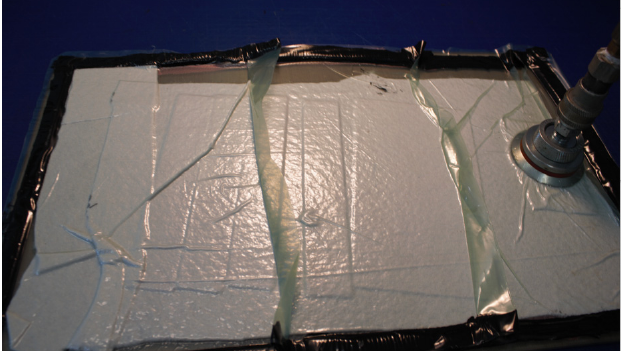
Figure 2. Manufactured process—vacuum package. The samples were rectangular plates with constant overall dimensions of 120 × 80 mm weakened by central cut-outs with variable geometric parameters a and b and with the constant corners’ rounded radius equal to 5 mm. On the shorter edges of the plate above and below the central cut-out, there are technological recesses with a width equal to the width of cut-out b, with the same radius as the cut-out corners. The task of the technological recesses was the constructional separation of zones, where only twisting and bending occur, without the effects of boundary conditions related to the fastening. Experimental validation of E-T and E-B couplings’ influence on plate behavior was per- formed using the Instron universal testing machine modernized by Zwick-Roell and equipped with specially designed grips (Figure 3). The experimental tests were performed at a constant velocity of the cross-bar equal to 2 mm/min and in ambient temperature. During the tests, force loading, plate displacement, and plate deflection in the perpendic- ular direction to the vertical strips of the plate in the middle of the height of the strip were measured. More details about experimental tests and results are given in previous articles [31,32]. ( a ) ( b ) Figure 3. ( a ) Universal testing machine illustrating the plate element under test; ( b ) specially de- signed grips.